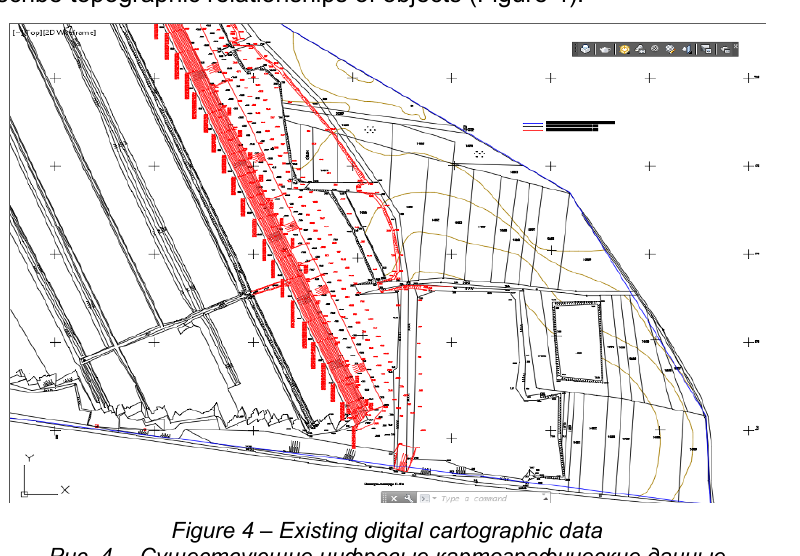
Figure 4 – Existing digital cartographic